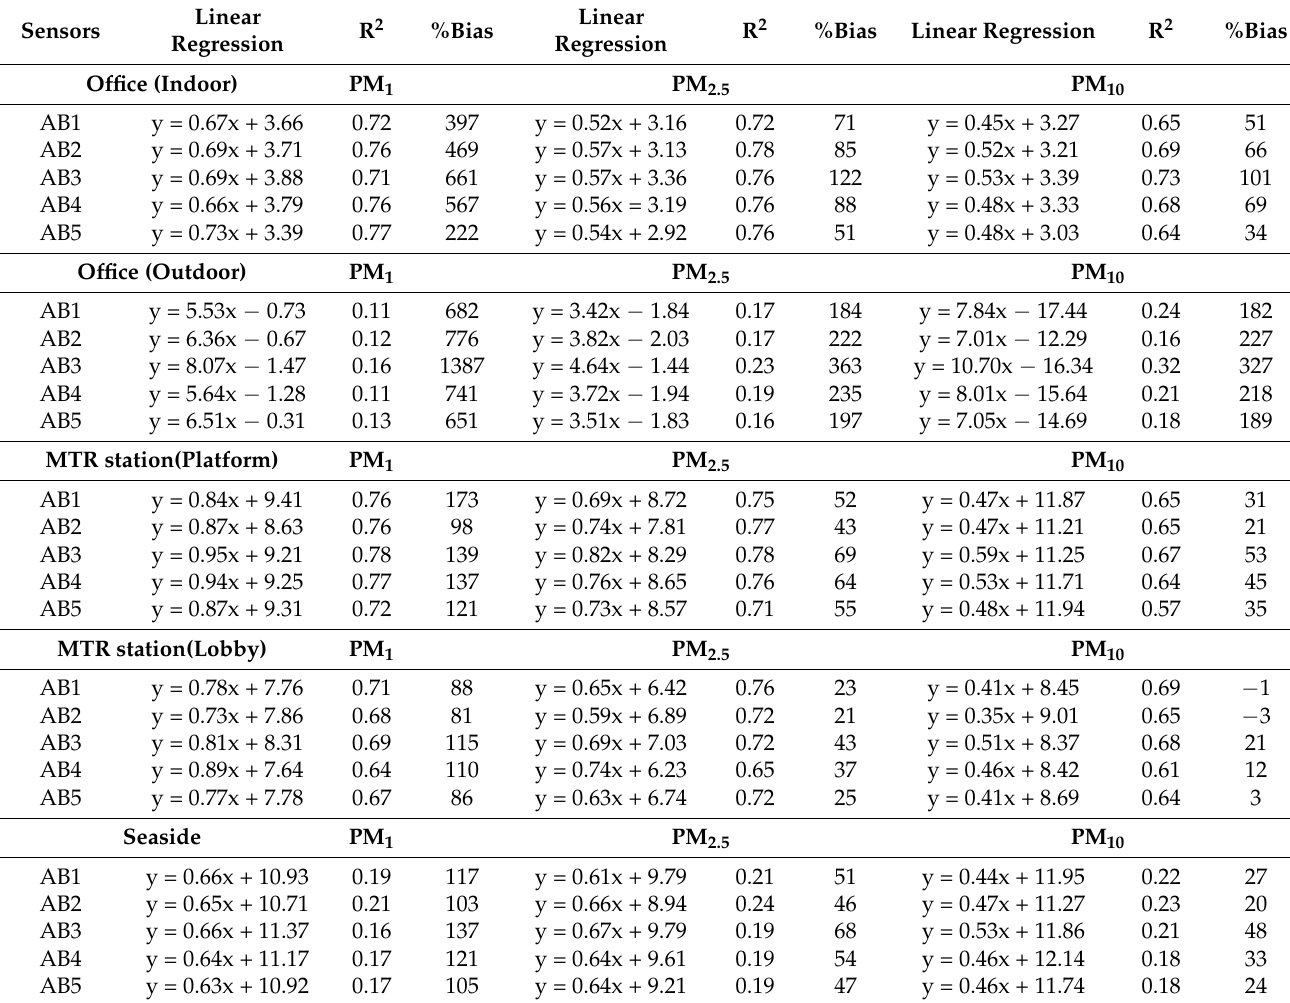
Table 3. Evaluation of 1 min PM 1 , PM 2.5 , and PM 10 average concentrations ( µ g/m 3 ) reported by AirBeam2 sensors compared with the DustTrak sensor in different